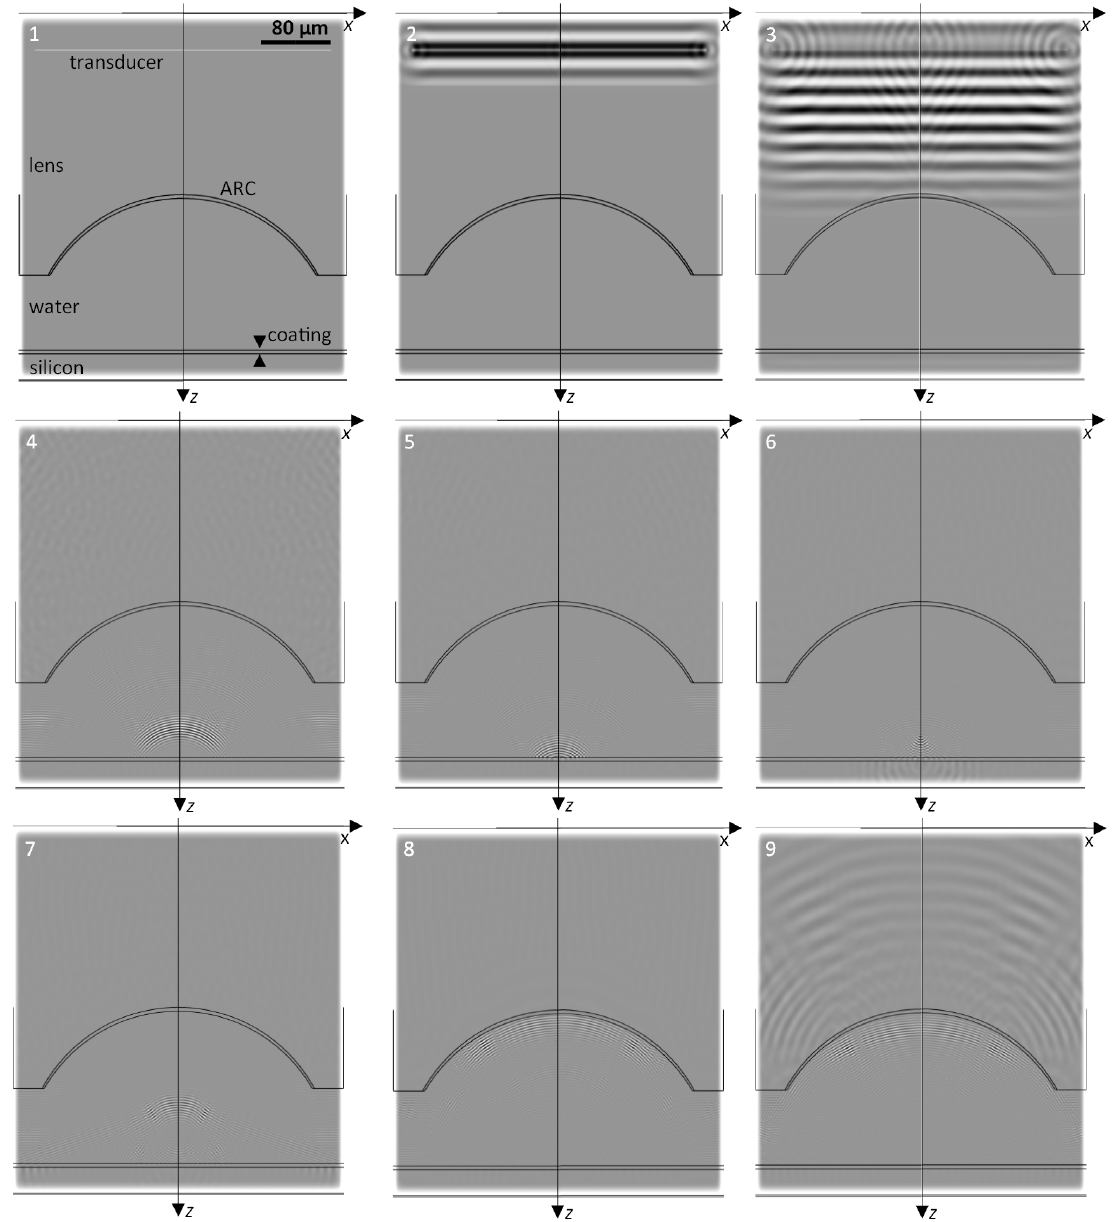
Figure 3. EFIT simulation of SAM measurement, time steps 1–9.